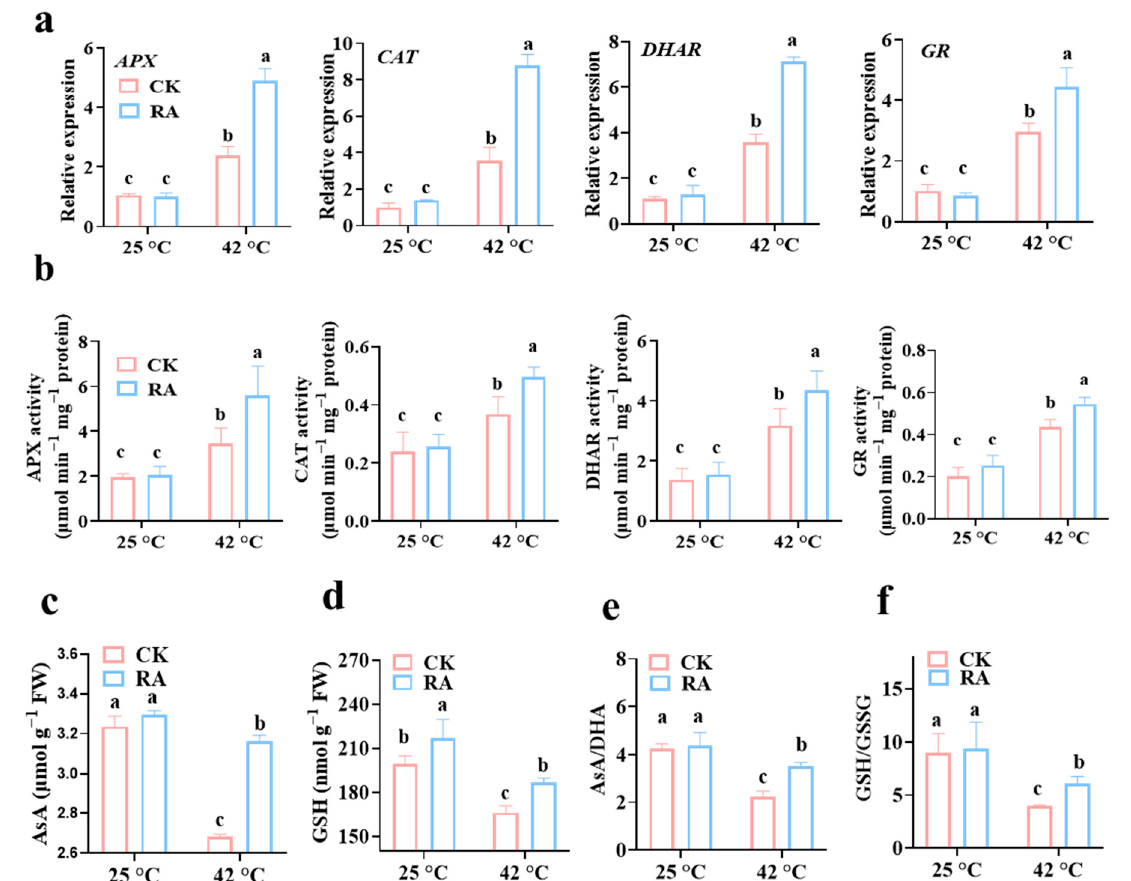
Figure 2. RA treatment activates the antioxidant system in tomato plants during high-temperature stress. ( a ) Effects of RA treatment on transcript abundance of antioxidant enzyme-encoding genes in tomato plants subjected to normal temperature (25 ◦ C) or high temperature (42 ◦ C) for 1 h. APX encodes an ascorbate peroxidase, CAT encodes a catalase, DHAR encodes a dehydroascorbate reductase, and GR encodes glutathione reductase. ( b ) Effects of RA treatment on enzyme activity of antioxidant enzymes in tomato plants subjected to different temperature conditions for 6 h. ( c ) Effects of RA treatment on AsA content in tomato plants subjected to different temperature conditions for 6 h. ( d ) Effects of RA treatment on GSH content in tomato plants subjected to different temperature conditions for 6 h. ( e ) Effects of RA treatment on AsA/DHA ratio in tomato plants subjected to different temperature conditions for 6 h. ( f ) Effects of RA treatment on GSH/GSSG ratio in tomato plants subjected to different temperature conditions for 6 h. The data presented are the mean values ± SD, n = 3. Statistically significant differences between treatments ( p < 0.05, Tukey’s test) are shown by different letters .